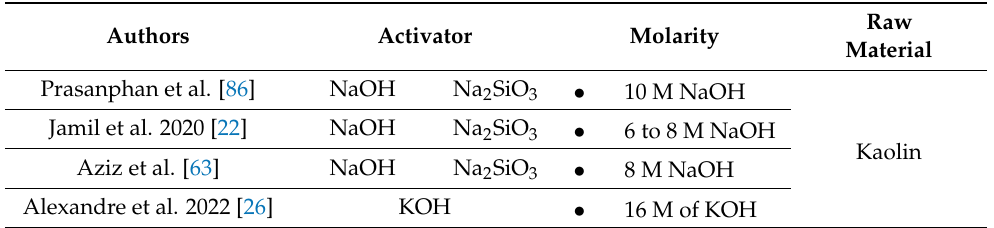
Table 5. Sintering temperature from past research.